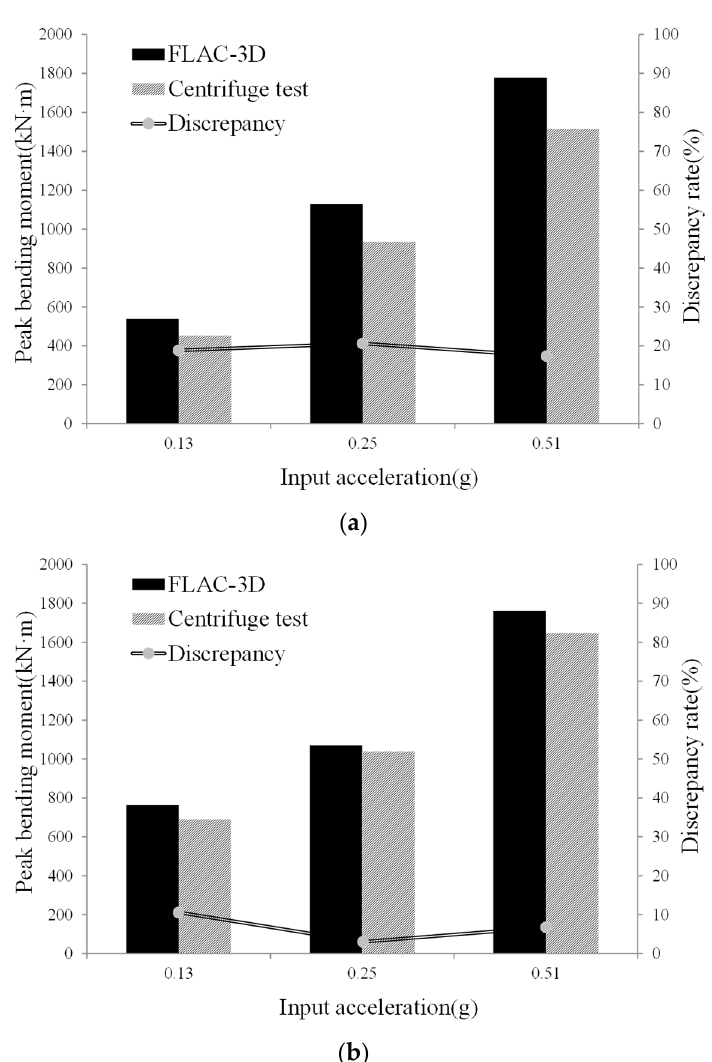
Figure 11. Measured and calculated maximum values of bending moments for various input amplitudes (Model 1): ( a ) Nisqually earthquake ; ( b ) Ofunato earthquake .